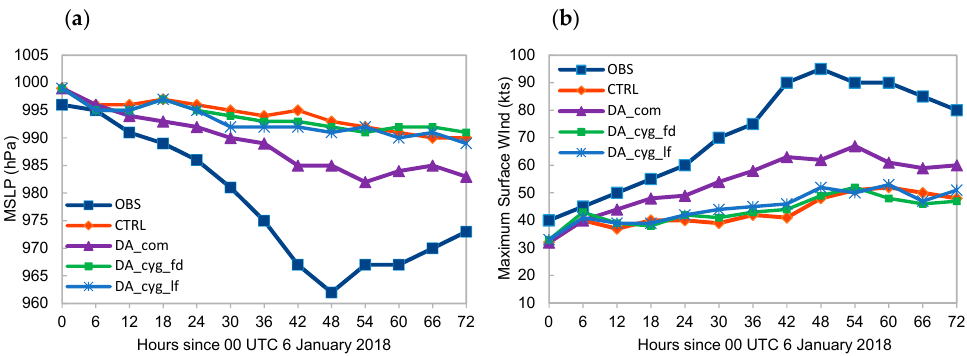
Figure 7. Time series of TC Irving intensity for ( a ) MSLP and ( b ) maximum surface wind speed from JTWC best track data, CTRL, DA_cyg_fd, DA_cyg_lf, and DA_com at 0000 UTC on 6–9 January 2018.